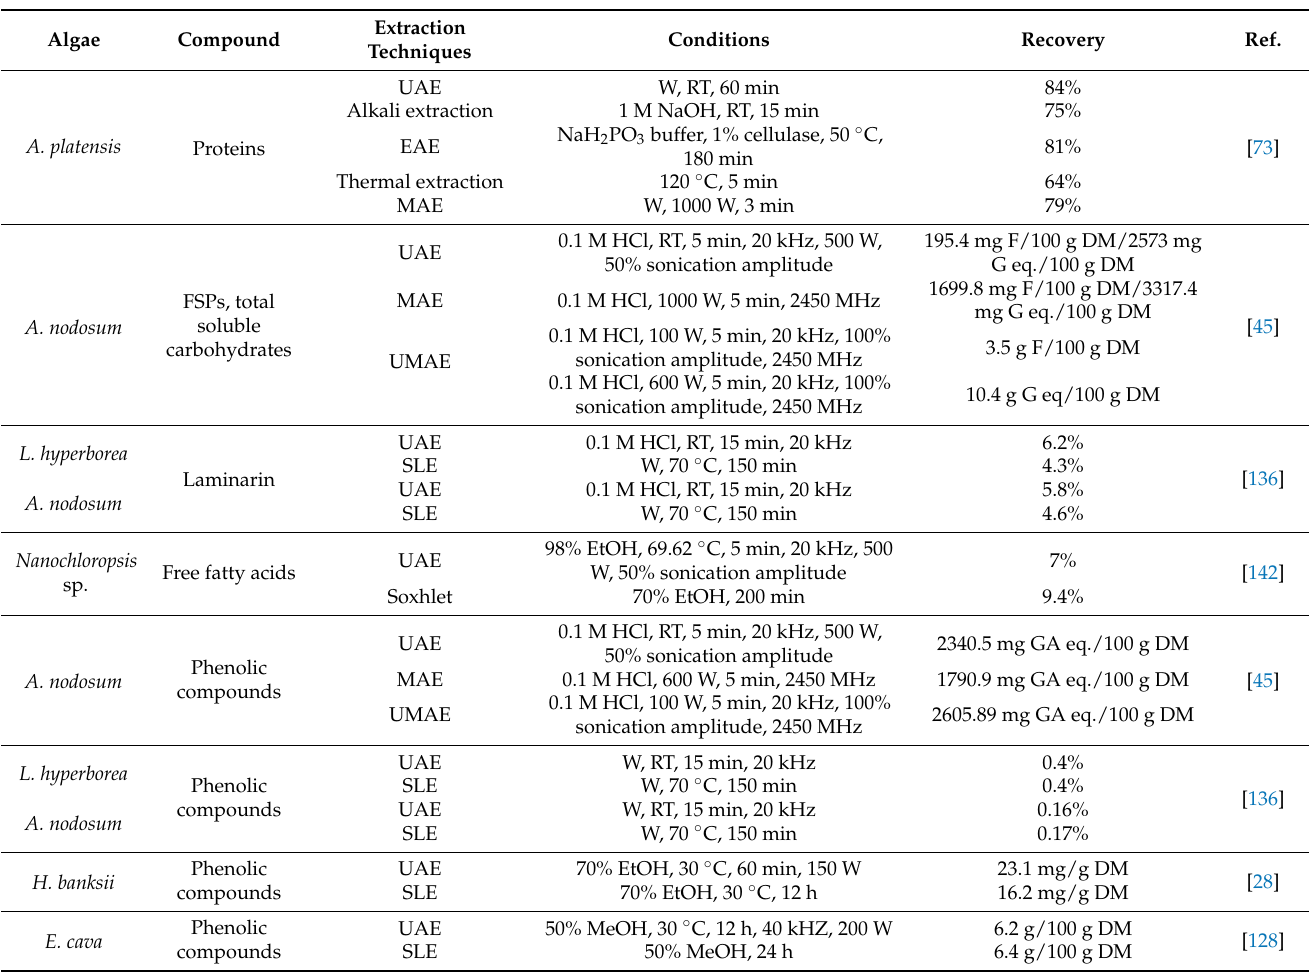
Table 4. Studies comparing the efficiency of UAE and other techniques in the recovery of algae BCs. Extraction Conditions Recovery Algae Compound Techniques